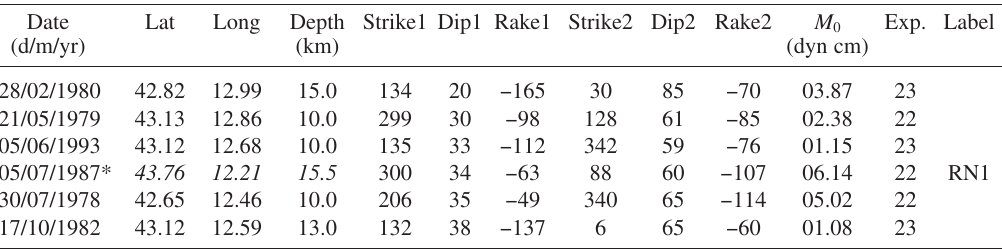
Table III. RCMT New. Parameters (strike, dip, and rake of the first and second nodal planes) of moment ten- sors obtained during the present study. The label RN represents RCMT, as described in the text. Events with * represent hypocentral locations sourced from: C1 – Deschamps et al. (1984); C2 – Collettini et al. (2003); C3 – Ciaccio et al. (2005); R1, R2, R4 and R5 – Chiaraluce et al. (2003); R7 and RN1 – Castello et al. (2005); R3 and D2 – present study; F10 – Di Luccio et al.